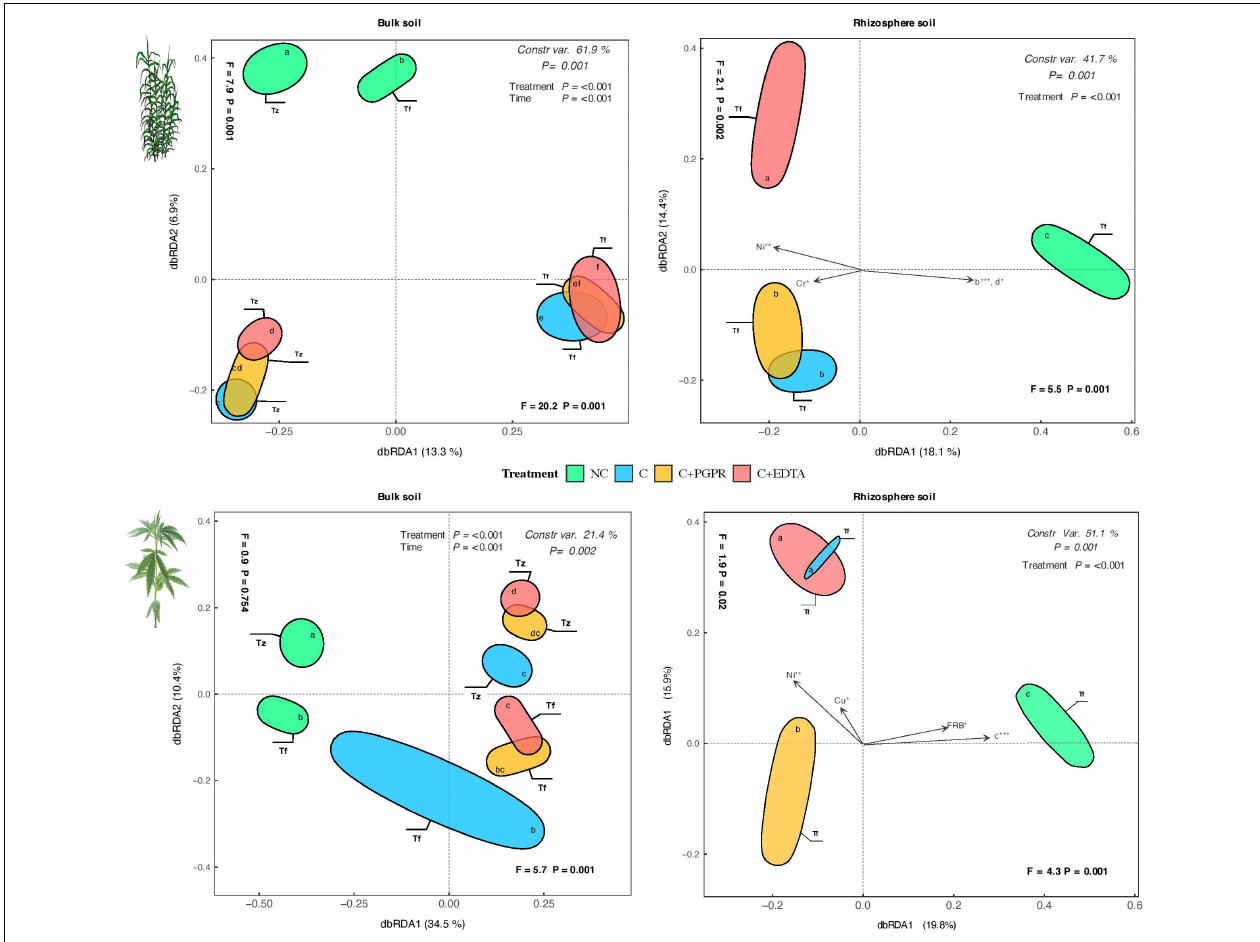
FIGURE 7 | Distance-based redundancy analysis (dbRDA) plots showing shifts in microbial diversity (OUT) of RS and BS of hemp and giant reed among treatments and sampling time. Arrow indicates environmental variables with significance level (* < 0.05, ** < 0.001, *** < 0.001). Letters within ellipses denote significant differences (Bonferroni’s test, P = 0.05) in OUT’s similarity matrices among treatments/sampling time combination as assessed by permutational multivariate analysis of variance